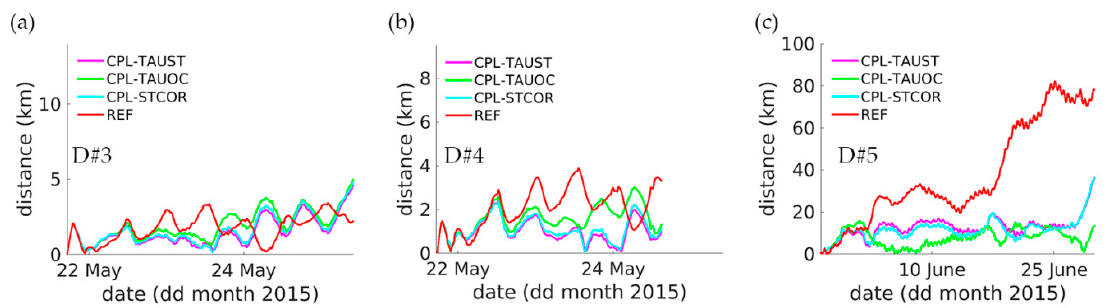
Figure 6. Time series of the separation distance (km) between the observed and model drifter #3 ( a ), #4 ( b ) and #5 ( c ) trajectories of REF (red line), CPL-TAUOC (green line), CPL-TAUST (magenta line) and CPL-STCOR (blue line) experiments.